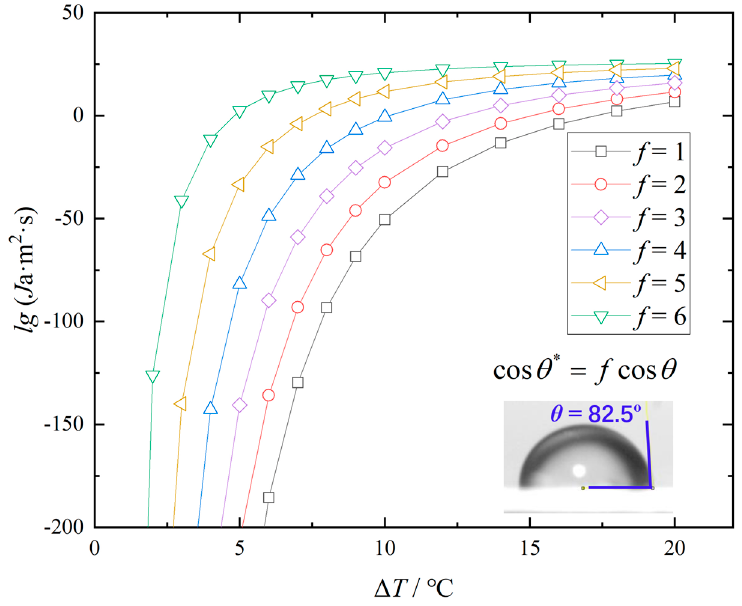
Figure 9. Heterogeneous nucleation rate under different supercooling and surface roughness (the inset shows the intrinsic contact angle of a smooth copper surface).